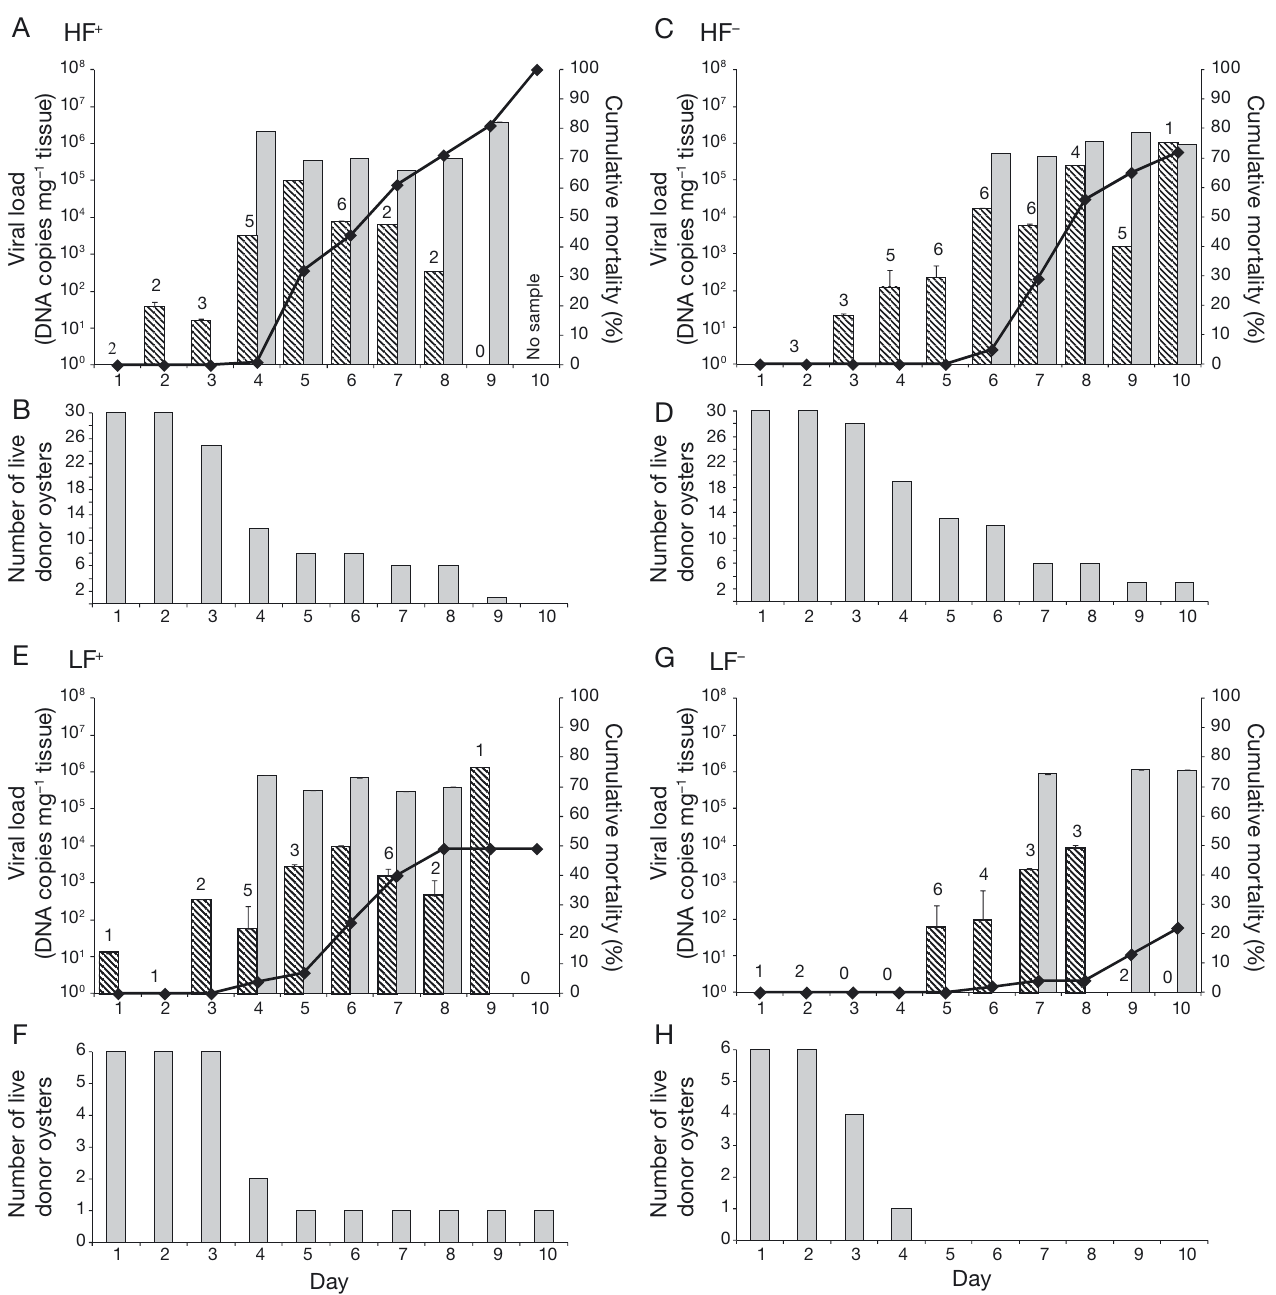
Fig. 1. (A,C,E,G) Cumulative mortality (%), adjusted for the effects of daily random sampling (line), mean (geometric) viral load (copies mg –1 of tissue, ± SD) of live sampled (striped bar) and dead cohabitated (solid grey bar) oysters (all that died that day) and the number of live infected oysters out of 6 (numbers over bars); and (B,D,F,H) the number of live donor oysters re- maining for each of the 4 treatment groups (see Table 1): (A,B) HF + , (C;D) HF − , (E,F) LF + , (G,H) LF − . SD is on the y -axis and where it is less than the viral load it is not visible above the Day 1 of the experiment at 13.20 DNA copies mg −1 tis- DNA was first detected in LF − live sampled oysters on sue.Quantitiesincreasedto9.78×10 3 ±4.64×10 2 DNA Day1(BLOD).OsHV-1wasdetectedat6.11×10 1 ±1.69 copies mg −1 tissue by Day 6. The infection percentage × 10 2 DNA copies mg −1 tissue on Day 5 and 8.46 × 10 3 ± increased from 16% on Day 1 to 100% by Day 6. The 3 1.46 × 10 3 DNA copies mg −1 tissue on Day 8. The infec- tionpercentagewas16%onDay1and100%onDay5, survivors in the LF + treatment all tested negative for OsHV-1attheendoftheexperimentalperiod.OsHV-1 then decreased to 33% by Day 9. OsHV-1 DNA was